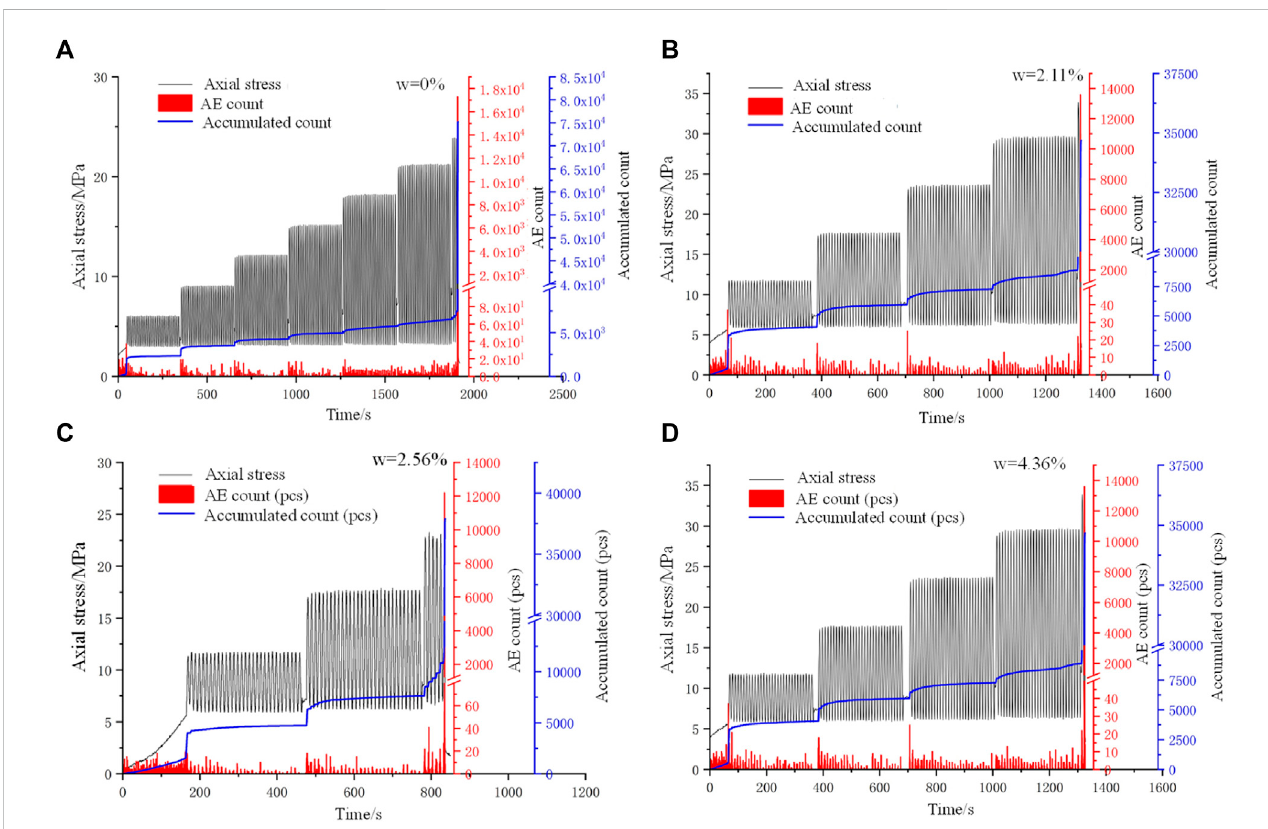
FIGURE 10 TheAEringcount andAEaccumulative ringcount distribution versus experimentaltime. (A-D) Thetested rocksampleswith watercontentof0%,2.21%, 2.56%, and 4.36%,